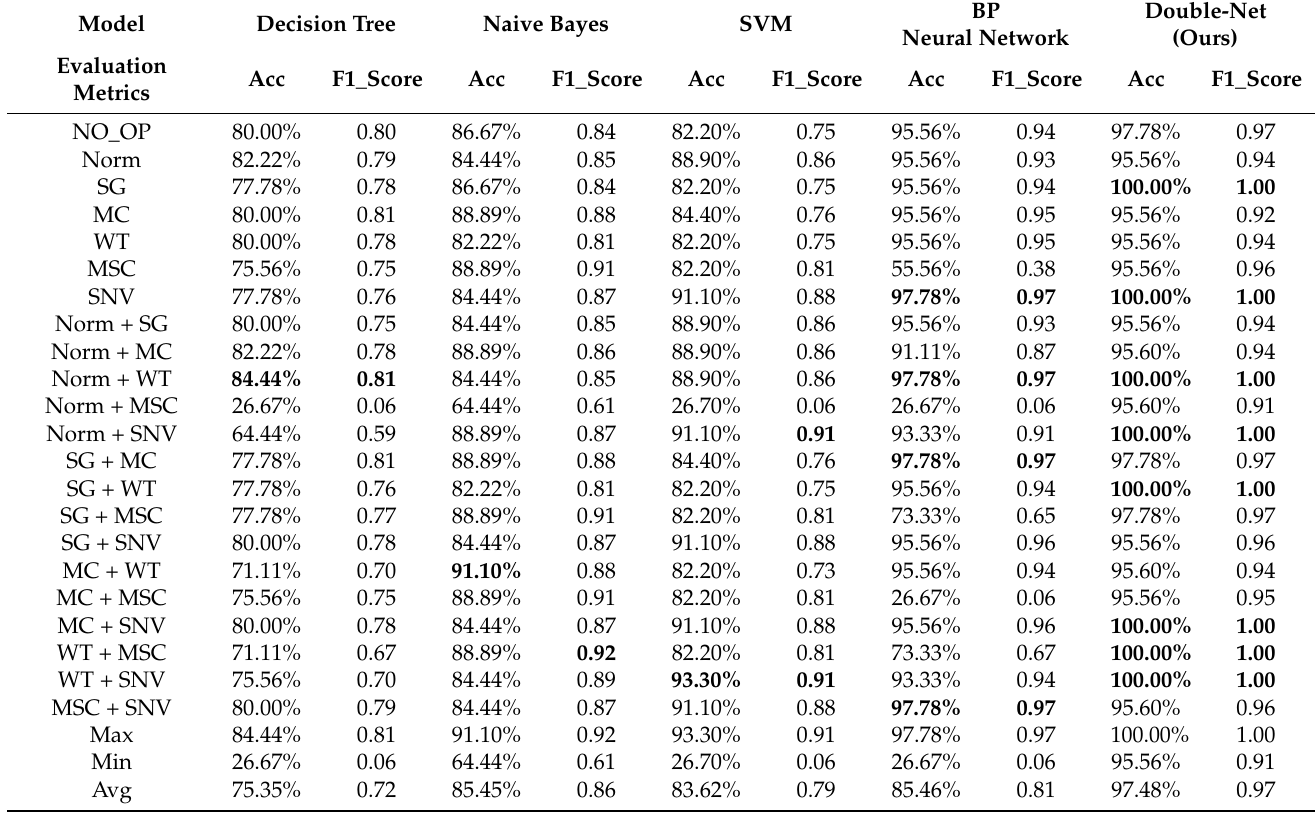
Table 1. Performance of each